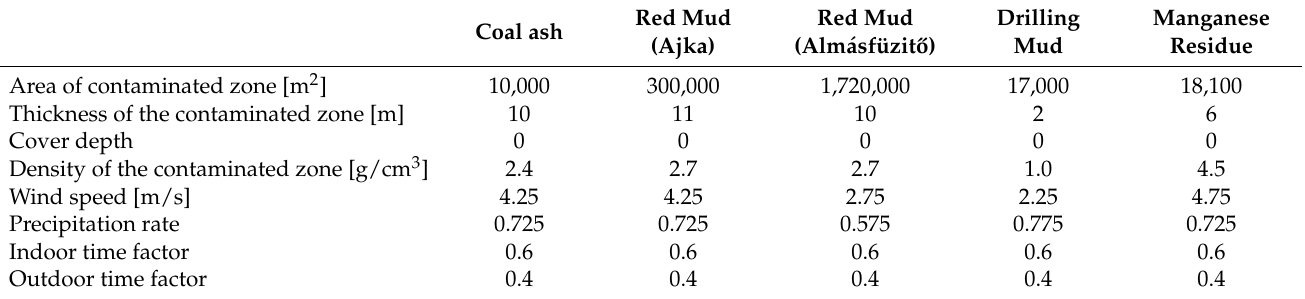
Table 1. Site-specific